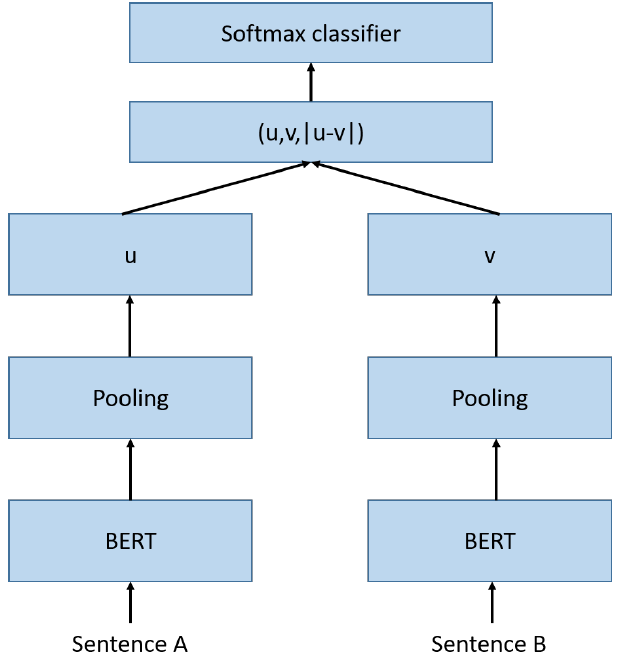
Figure 2. SBERT architecture with classification goals, for fine-tuning on the SNLI open dataset. The weights of the two BERT networks are the same.